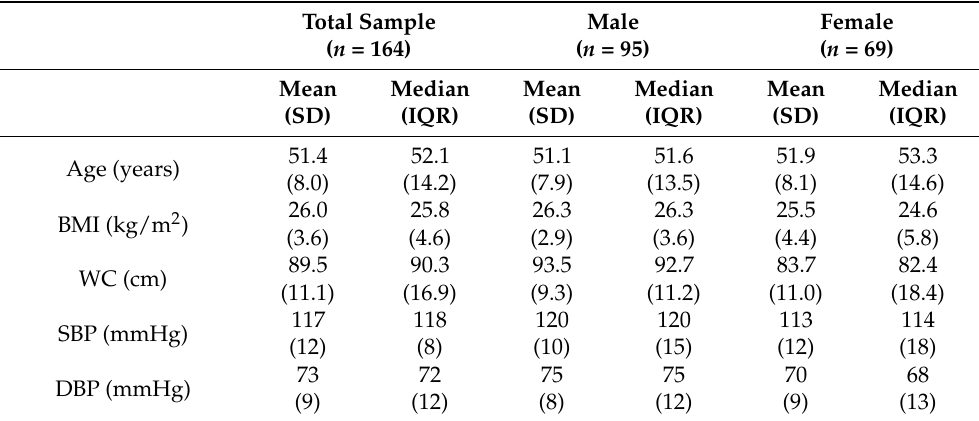
Table 2. Sociodemographic and clinical characteristics of the participants who participated in the validity